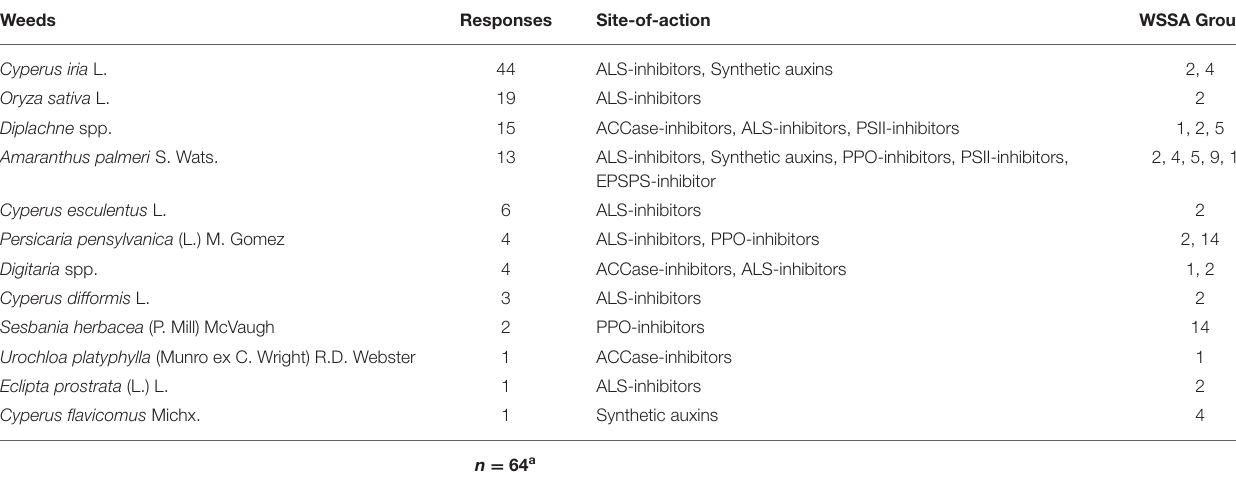
TABLE 4 | Weed species [excluding Echinochloa crus-galli (L.) P. Beauv.] suspected of herbicide resistance as reported by survey respondents and the herbicide site-of-action and WSSA Group # to which they are suspected resistant to. Weeds Responses Site-of-action WSSA Group # Cyperus iria L. 44 ALS-inhibitors, Synthetic auxins 2, 4 Oryza sativa L. 19 ALS-inhibitors Diplachne